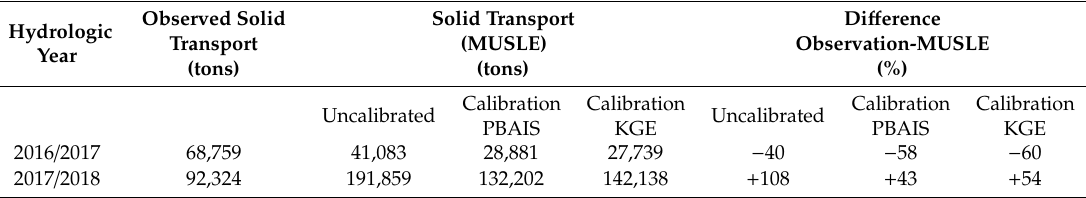
Table 17. Results of the MUSLE model at Ain Loudah on the Korifla and comparison with observations.